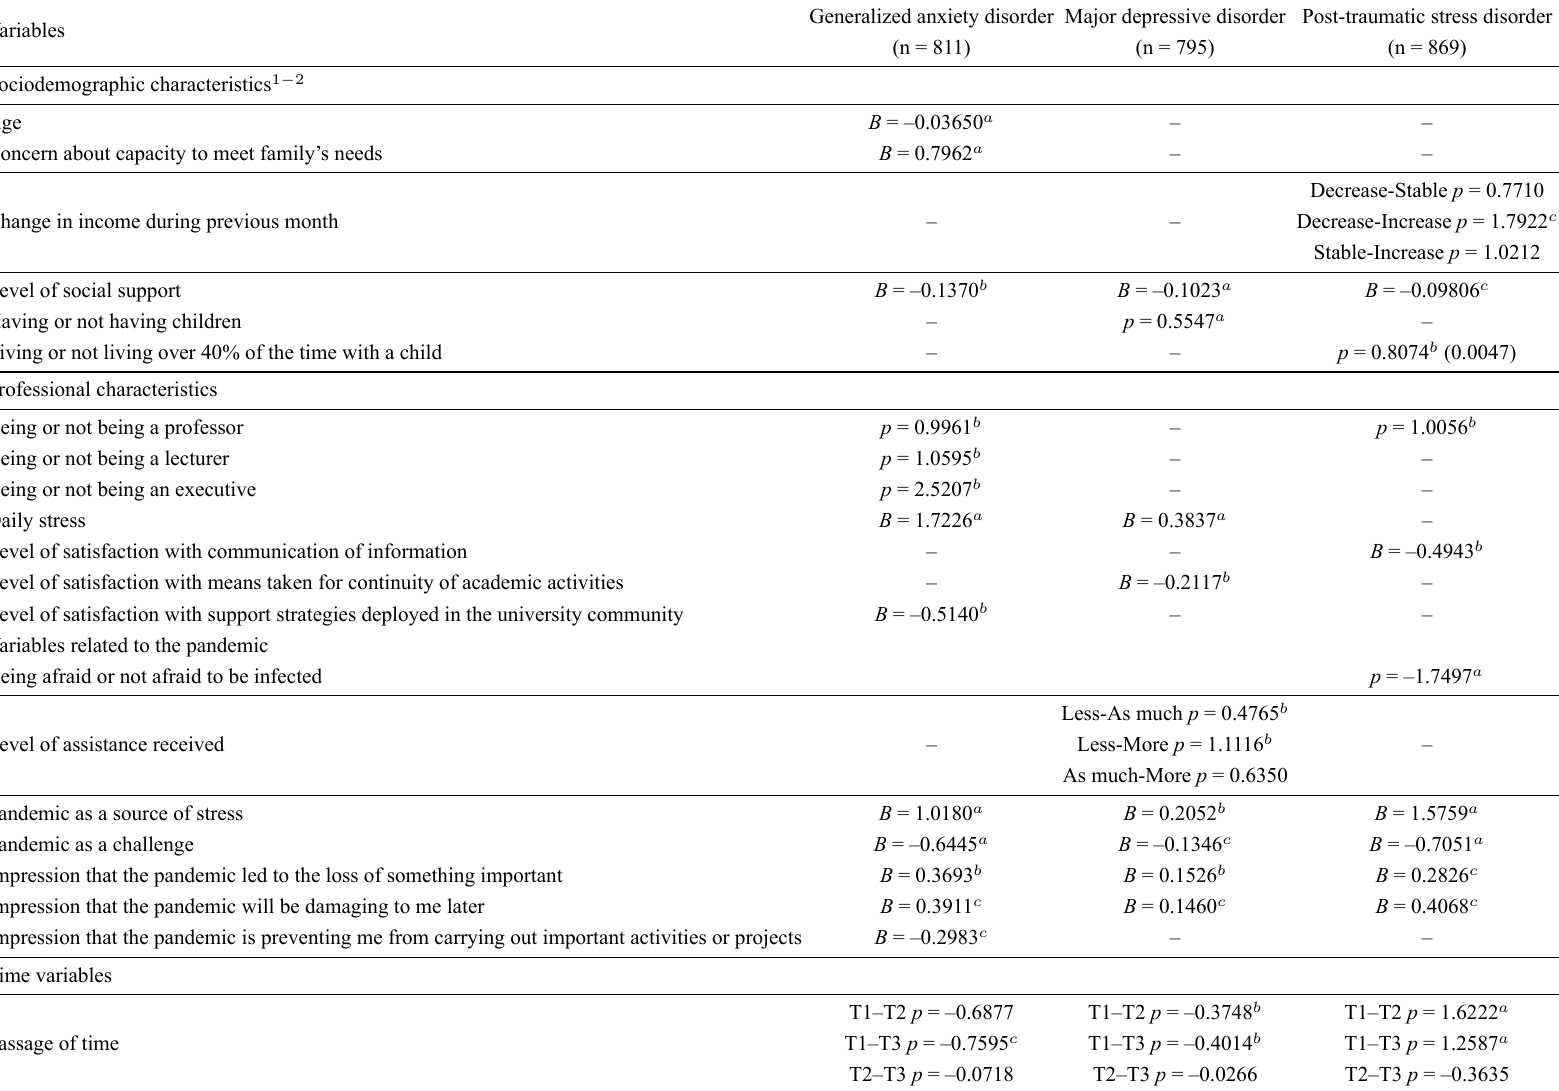
Table 3. Tests of fixed